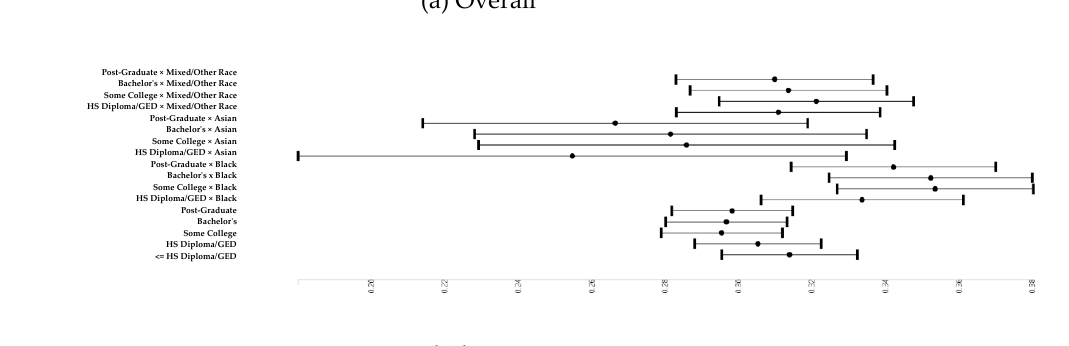
Figure 2. Association between parental education and left cerebellum cortex fractional anisotropy overall and by race.